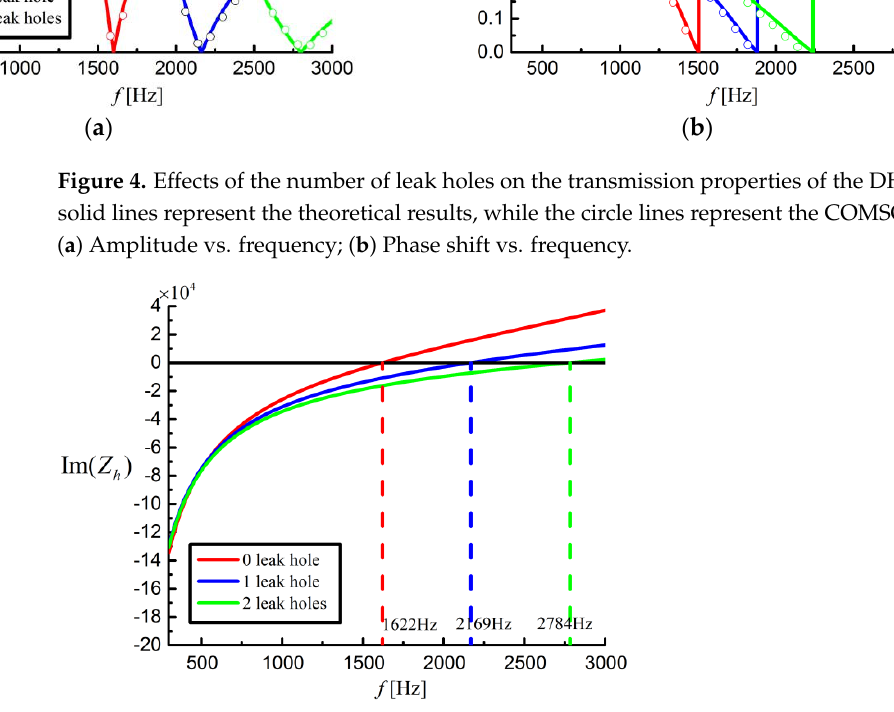
Figure 5. Overall impedance vs. frequency.